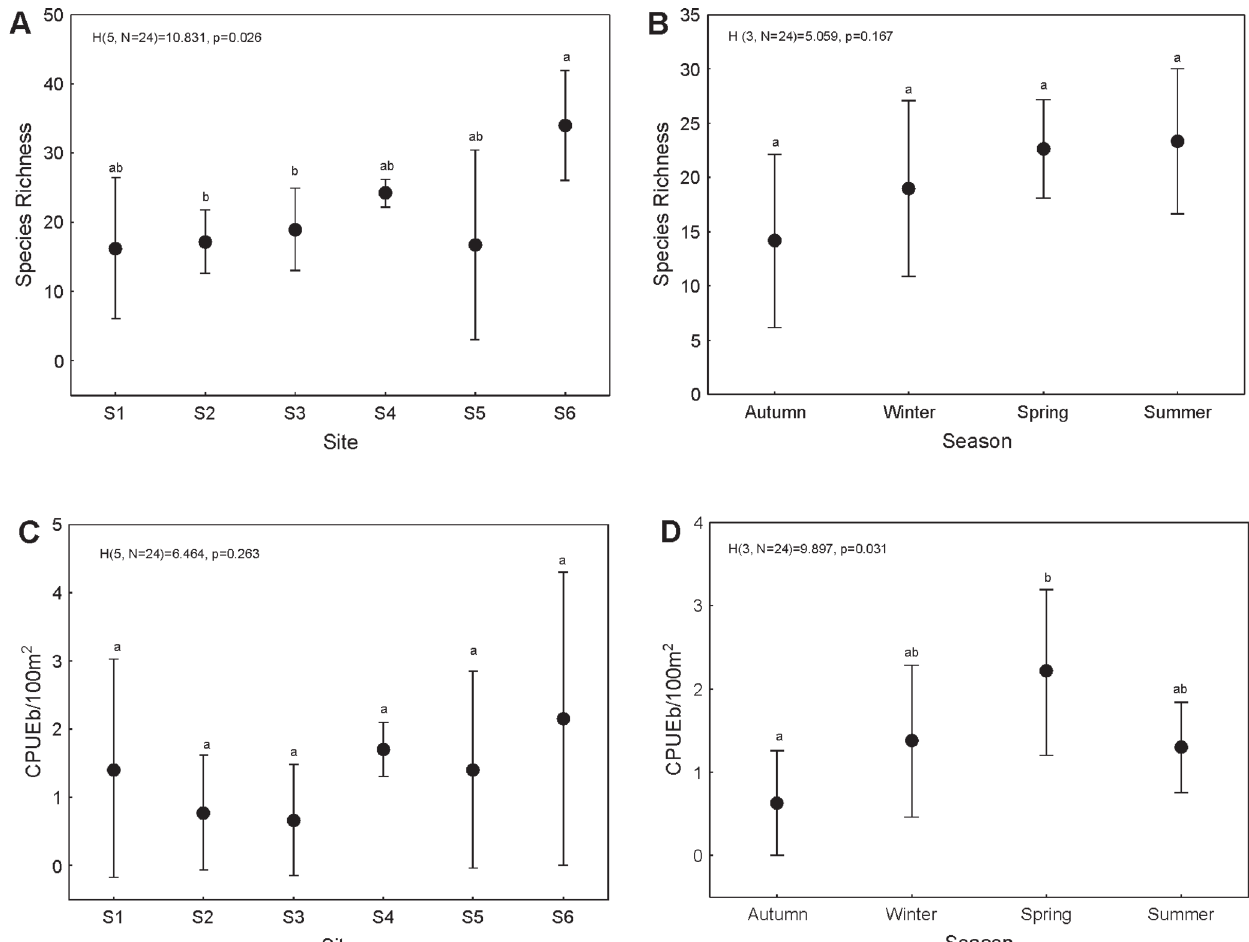
Fig. 2. Variation (mean ±standard deviation) in species richness and biomass (CPUEb/100m 2 ) along the river channel (A and C) and among seasons (B and D), in the Middle Uruguay River. Sites: S1 = upstream; S6 = downstream. Different letters indicate statistical difference (p <